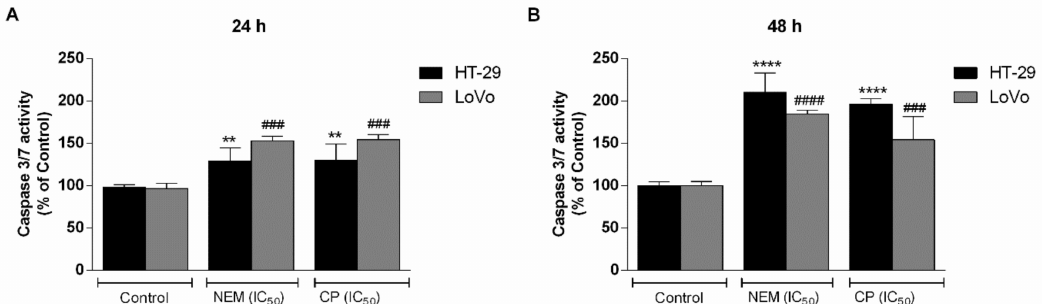
Figure 6. Activation of caspase 3 / 7 in CRC cell lines after a 24 h-( A ) and 48 h-( B ) treatment with NEM or CP (IC 50 / 72 h). The caspase 3 / 7 activity is expressed as percentage of fold change with respect to untreated cells. The values are normalized to the amount of living cells. Data are expressed as mean ± S.D. of three independent experiments. HT-29 cells: ** p < 0.01, **** p < 0.0001 vs. untreated cells. LoVo cells: ### p < 0.001, #### p < 0.0001 vs. untreated